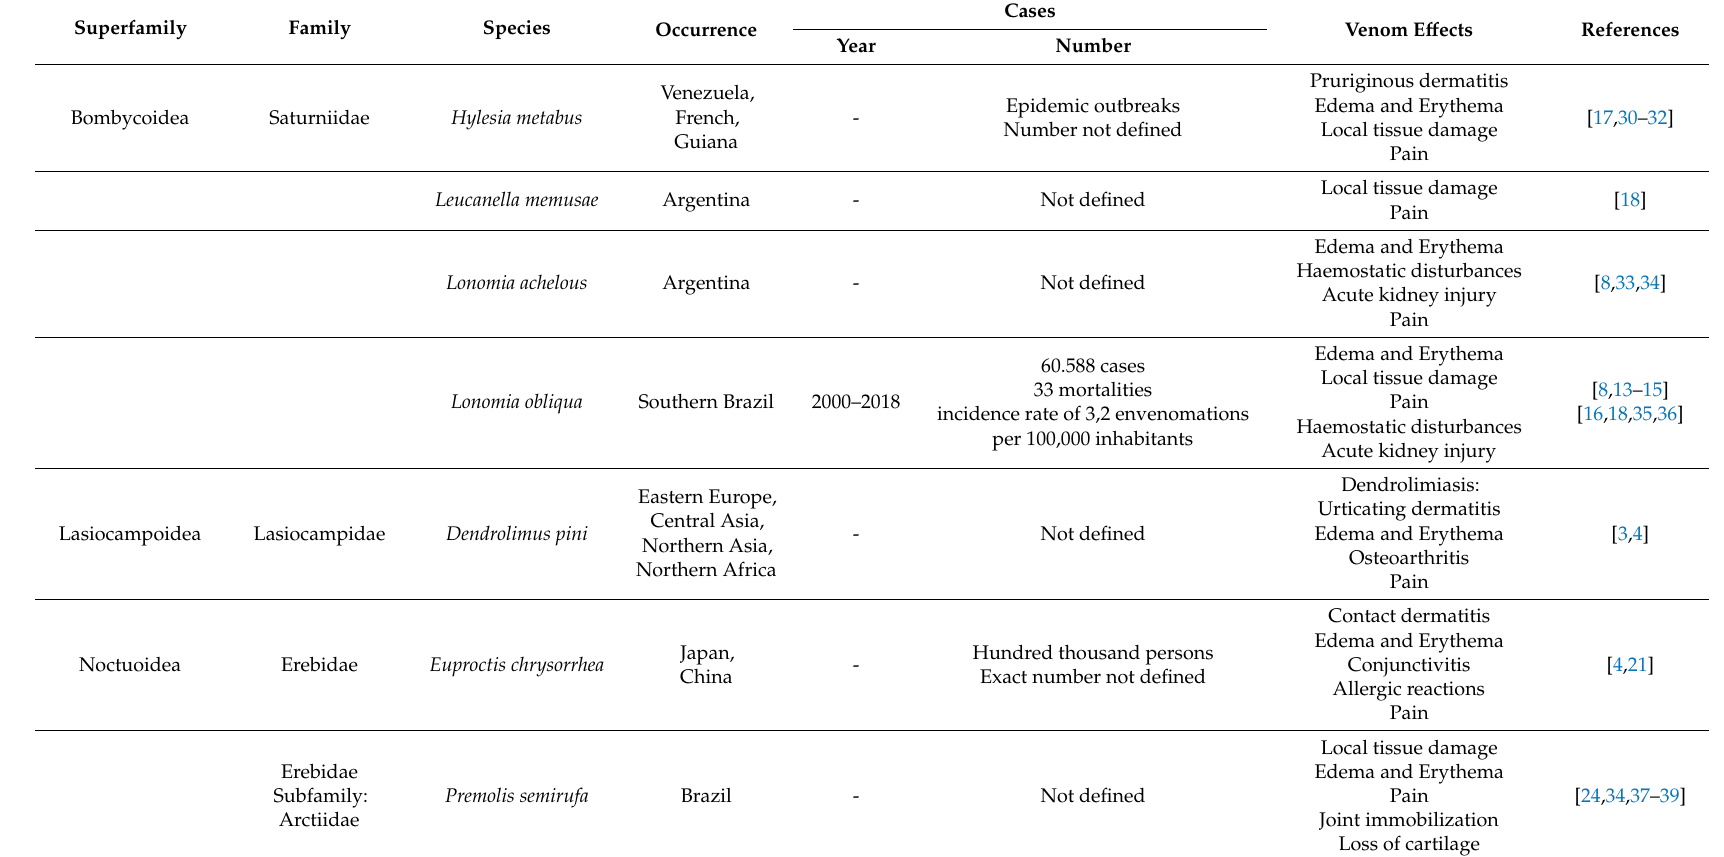
Table 1. Occurrence, cases and venom e ff ects from caterpillars of moths described in this review. The table shows seven of the nine venomous caterpillar families. For the Eucliedae and Nymphalidae family, no reference in the literature was found of envenomation